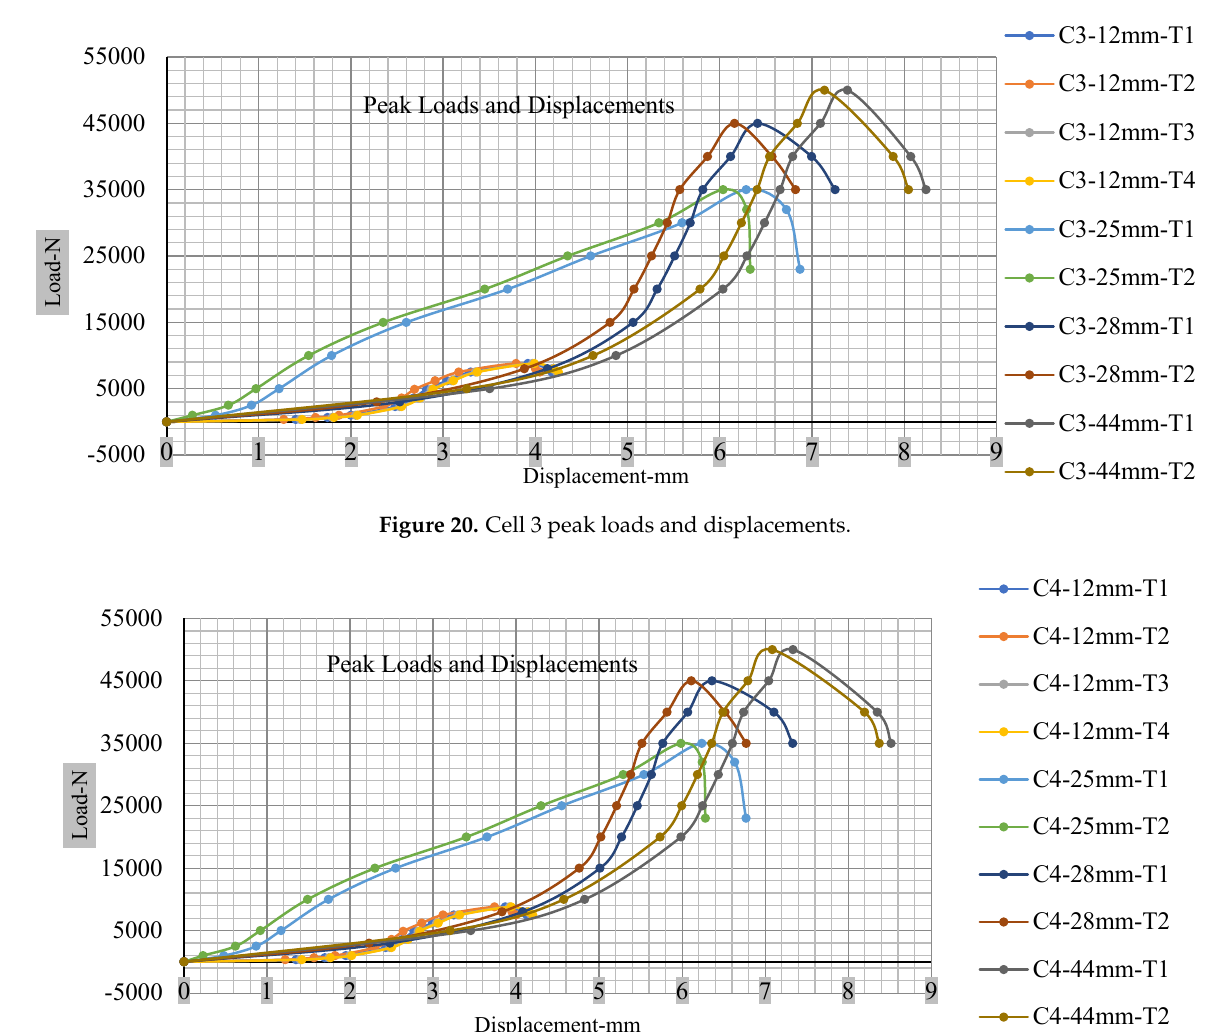
Figure 19. Cell 2 peak loads and displacements.